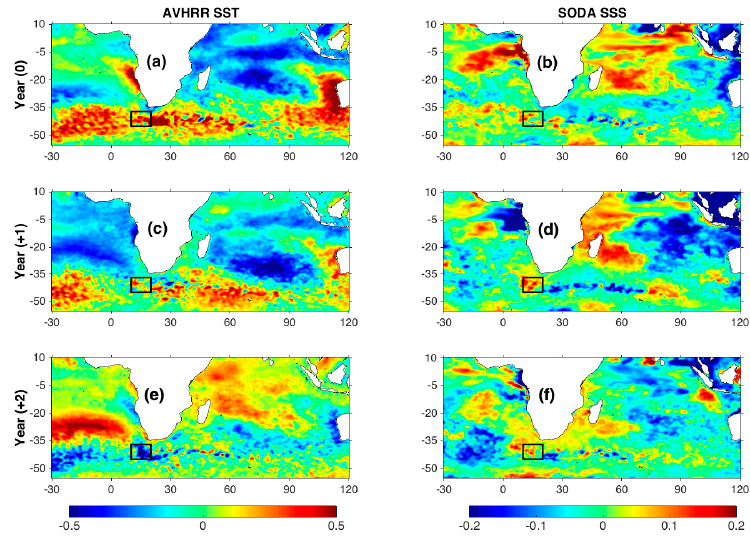
Figure 1. Composite mean for all La Niña events listed in Table 1 from January–March for both Advanced Very High Resolution Radiometer (AVHRR) sea surface temperature (SST) anomalies (left column) and Simple Ocean Data Assimilation (SODA) sea surface salinity (SSS) anomalies (right column) during the peak ( a , b ), the following year ( c , d ), and two years after ( e , f ). The boxes represent the established leakage region (37°–45°S, 10°–20°E).